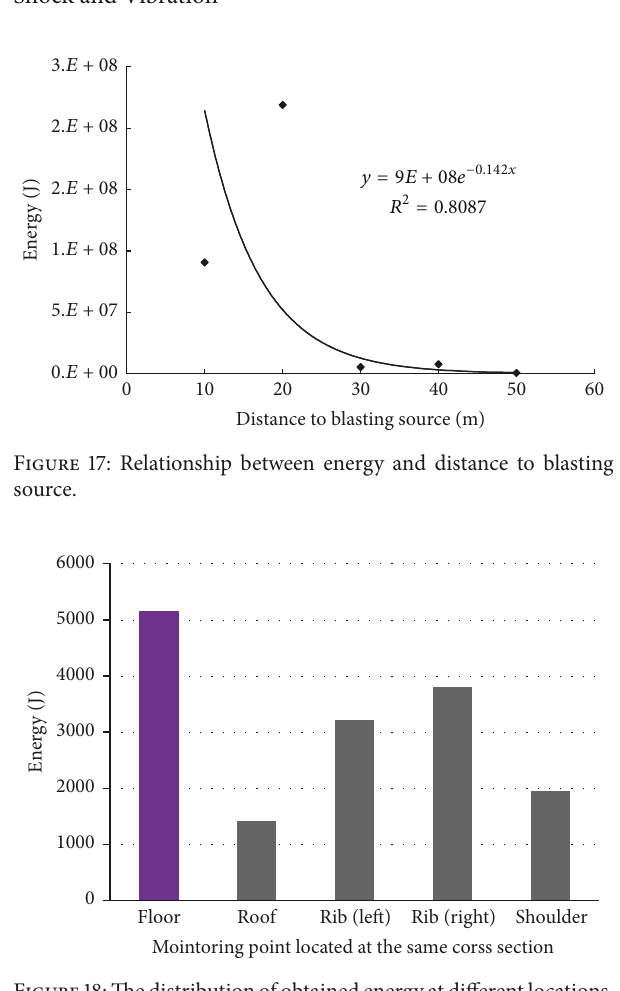
Figure 18: The distribution of obtained energy at different